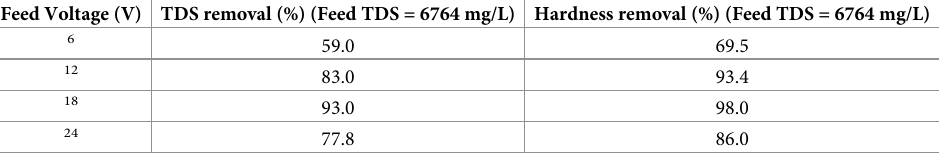
Table 2. TDS removal percentage in EDR at different voltages. (Feed flow rate = 12 L/h, water recovery ratio for TDS 6764 mg/L = 75% and feed temperature =